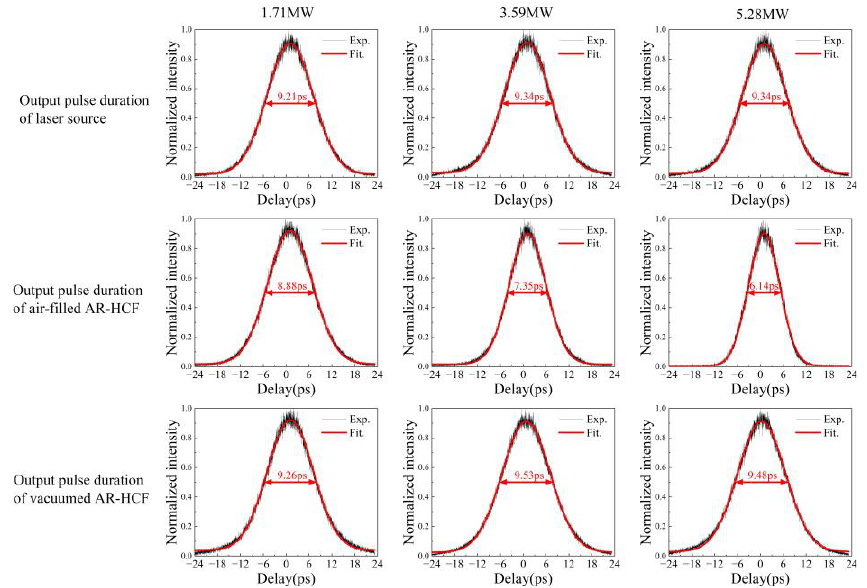
Figure 9. Measurement pulse duration of laser source, air-filled AR-HCF and vacuumed AR-HCF at peak power of 1.71 MW, 3.59 MW and 5.28 MW .